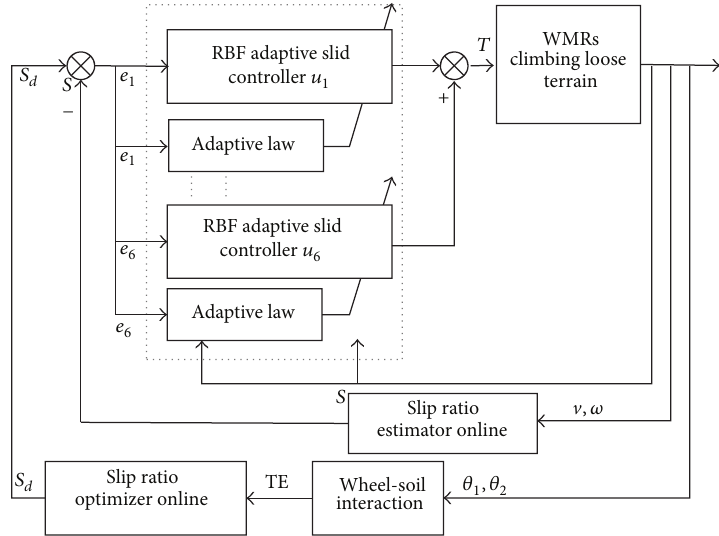
Figure 7: Flowchart for optimal slip ratio tracking control based on RBF neural network adaptive sliding mode.